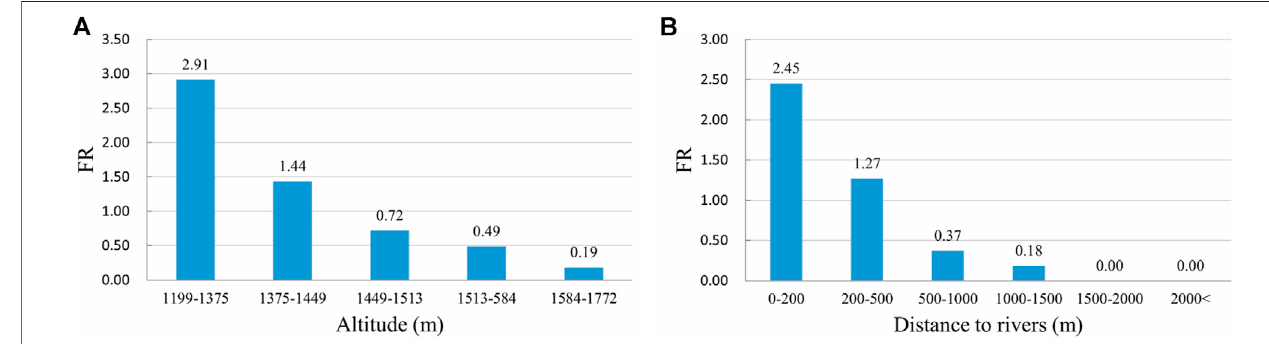
FIGURE 12 | Frequency ratio chart of altitude and distance to rivers. (A) altitude, (B) distance to